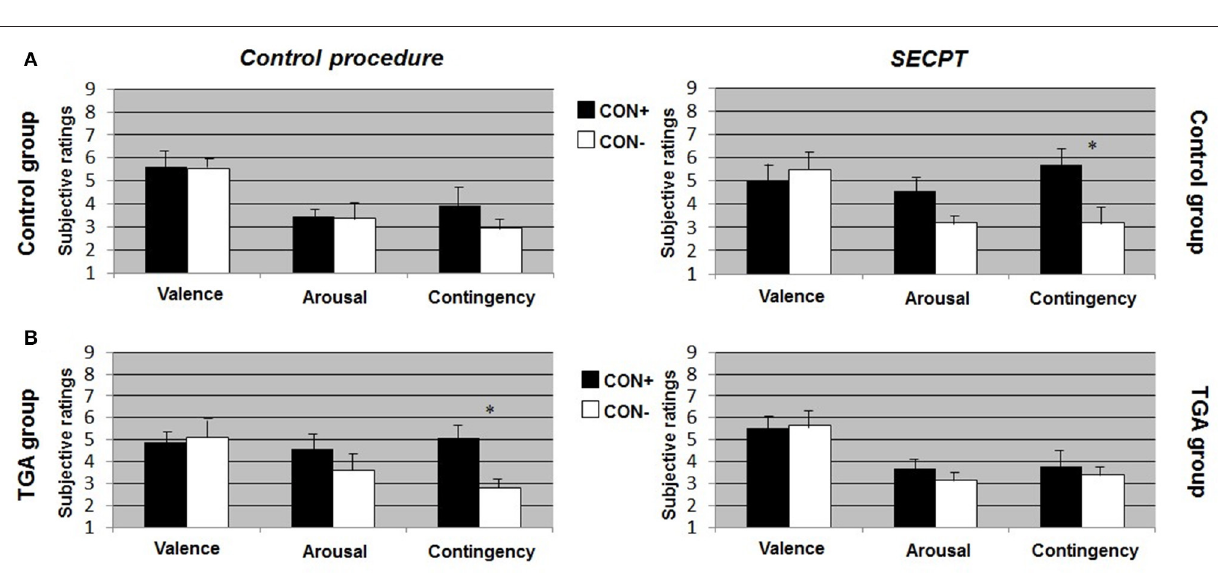
FIGURE 3 | Subjective ratings of valence, arousal and contingency during the extinction phase of the contextual fear conditioning paradigm. (A) In the control group, (B) in the TGA group, following the control procedure and the SECPT. * p < 0.05. CON + , conditioned stimulus paired with the unconditioned stimulus; CON − , conditioned stimulus never paired with the unconditioned stimulus; SECPT, Socially Evaluated Cold Pressor Test; TGA, transient global